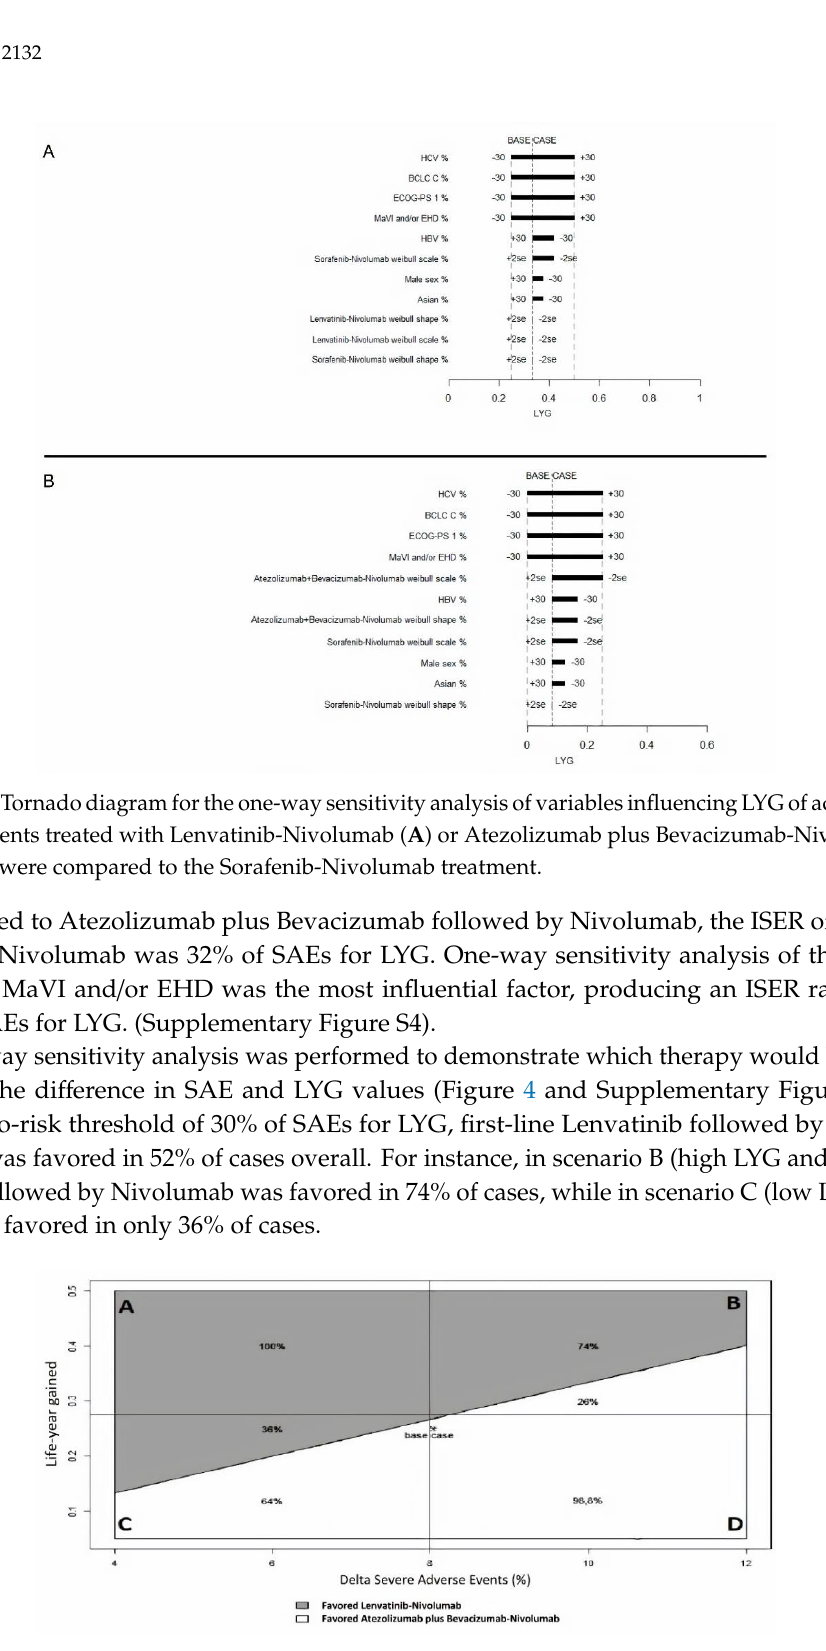
Figure 4. Two-way sensitivity analysis of ISER (Delta Severe Adverse Events%/Life-year gained) to indicate which therapy is favored for varying Severe Adverse Events (SAEs) and LYG (Life-Year Gained) values, according to a “willingness-to-risk” threshold of 30% of SAEs for LYG. Grey area favored Lenvatinib-Nivolumab, while white area favored Atezolizumab plus Bevacizumab-Nivolumab. Four clinical scenarios were modeled: ( A ) high LYG, low SAEs; ( B ) high LYG, high SAEs; ( C ) low LYG, low SAEs; ( D ) low LYG, high SAEs.